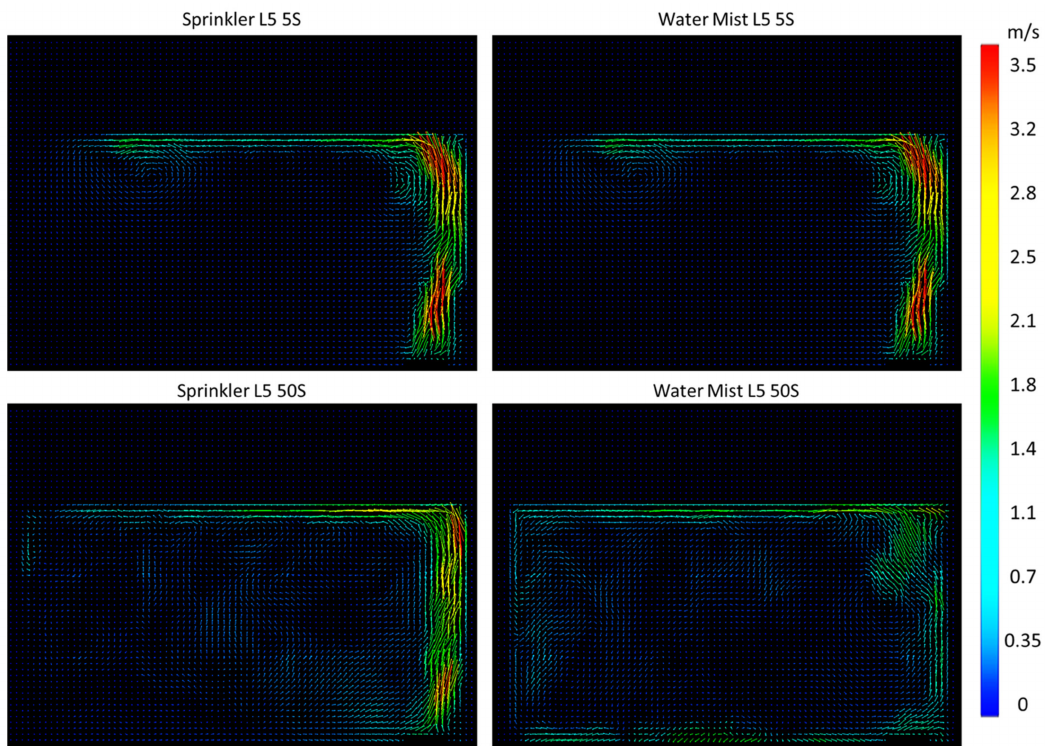
Figure 11. Velocity vector for sprinkler and water mist systems at location 5, before and during fire